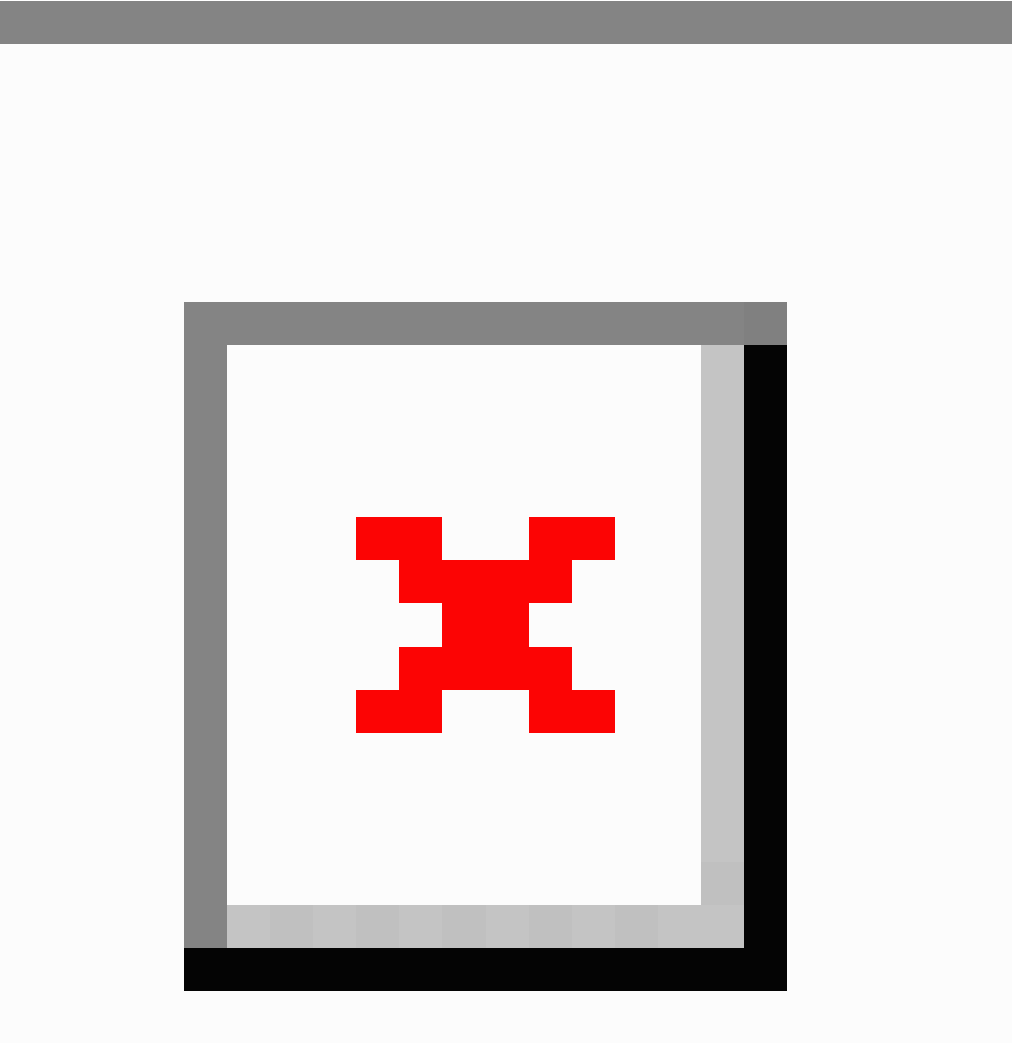
Figure 1. Example of how the different dimensions of the VP case were structured to be congruent with the Calgary Cambridge Guides and the PRACTICAL training model in communication